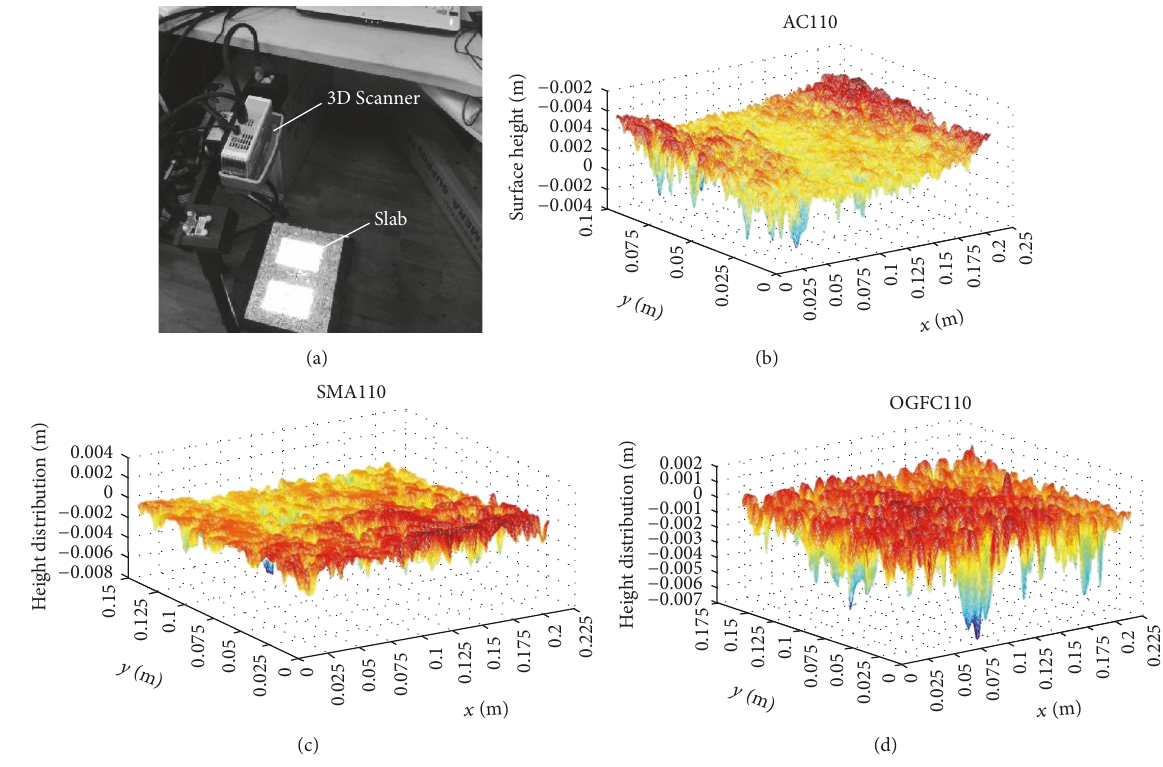
Figure 1: Pavement topography characterization: (a) three-dimensional optical scanner; (b) AC; (c) SMA; (d) OGFC.